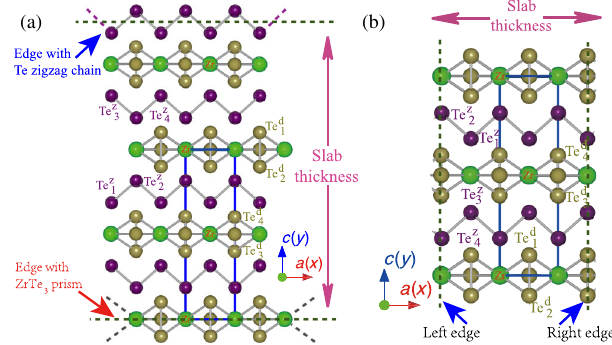
FIG. 7 (color online). A schematic picture of the 40-unit-cell- thick slab used to calculate edges states. (a) The asymmetric slab terminated with a Te zigzag chain and a ZrTe 3 prism chain for the x edge. (b) The symmetric slab for the y edge.